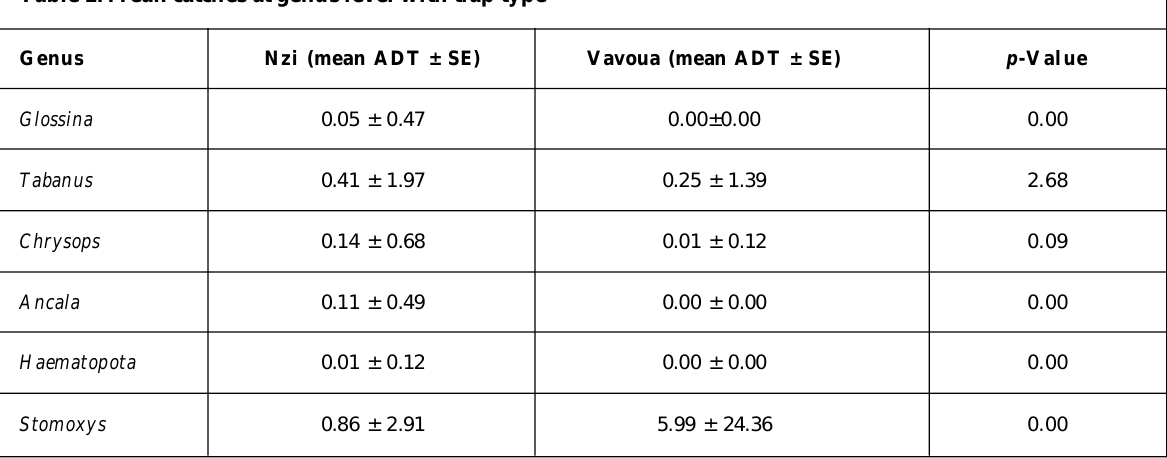
Table 2: Mean catches at genus level with trap